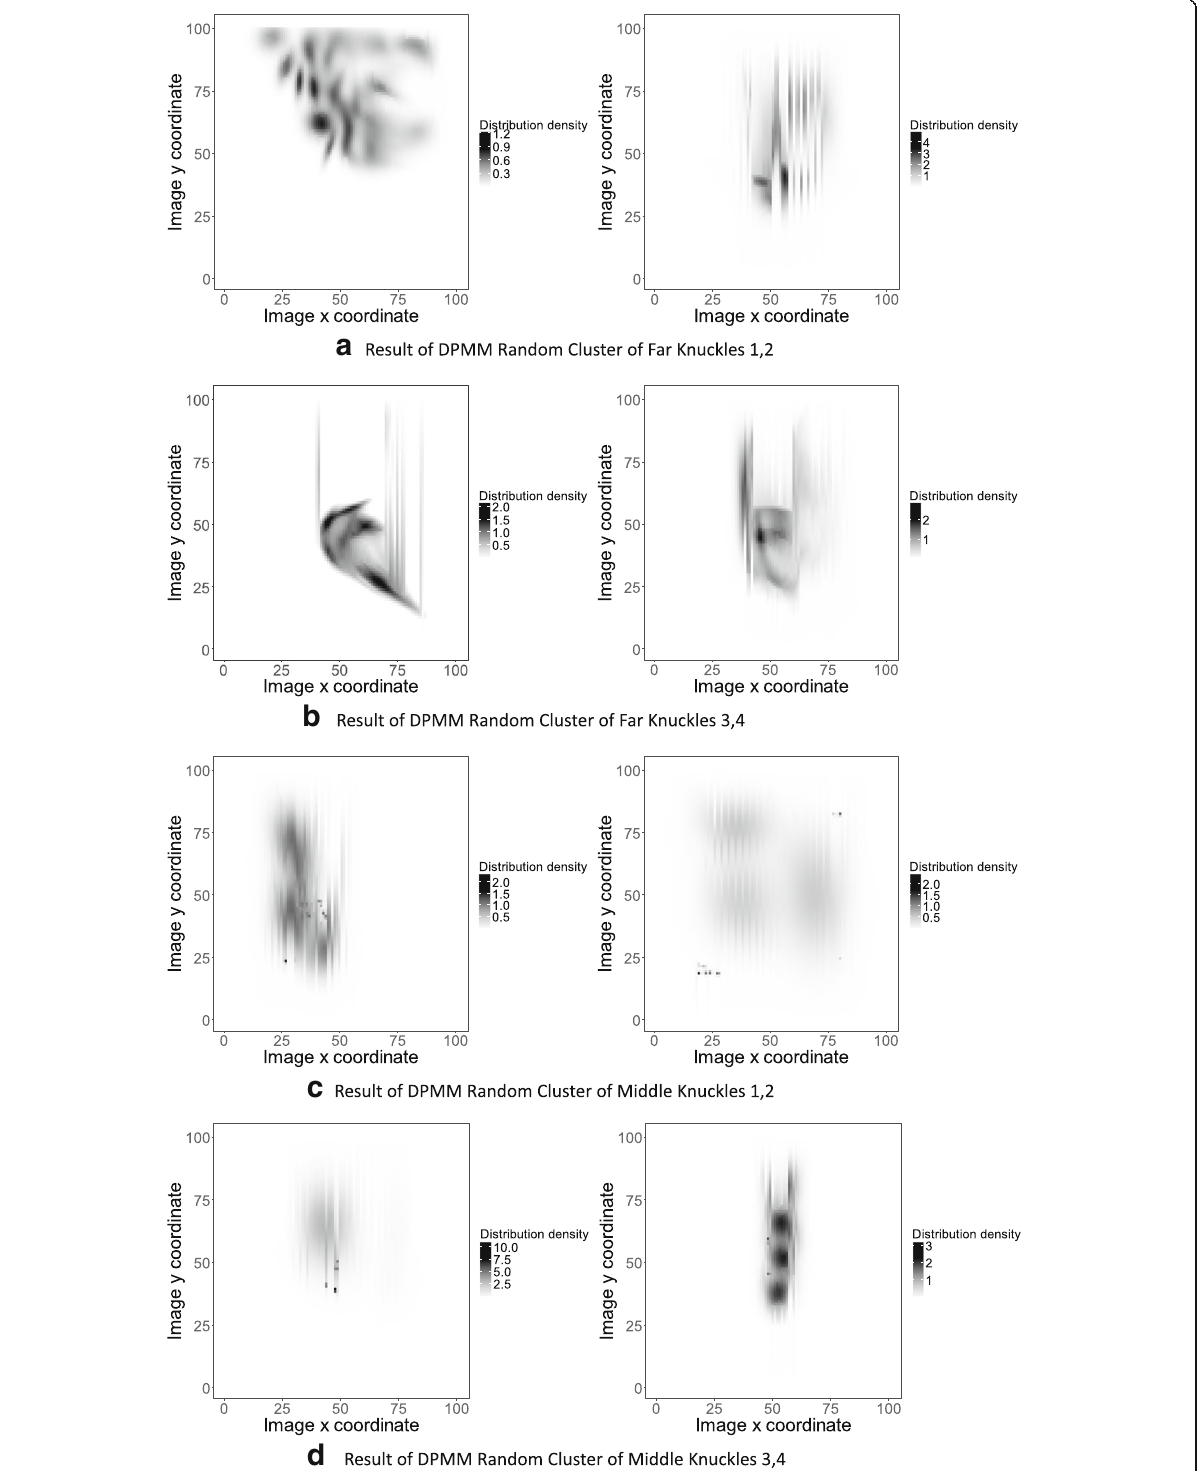
Fig. 6 Results of DPMM random cluster of knuckles. a Result of DPMM random cluster of far knuckles 1 and 2. b Result of DPMM random cluster of far knuckles 3 and 4. c Result of DPMM random cluster of middle knuckles 1 and 2. d Result of DPMM random cluster of knuckles 3 and